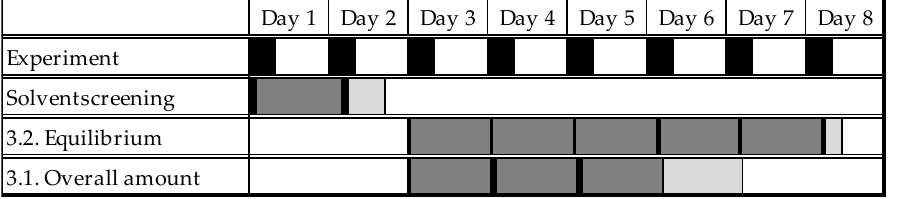
Figure 12. Schedule of the parameter determination process.